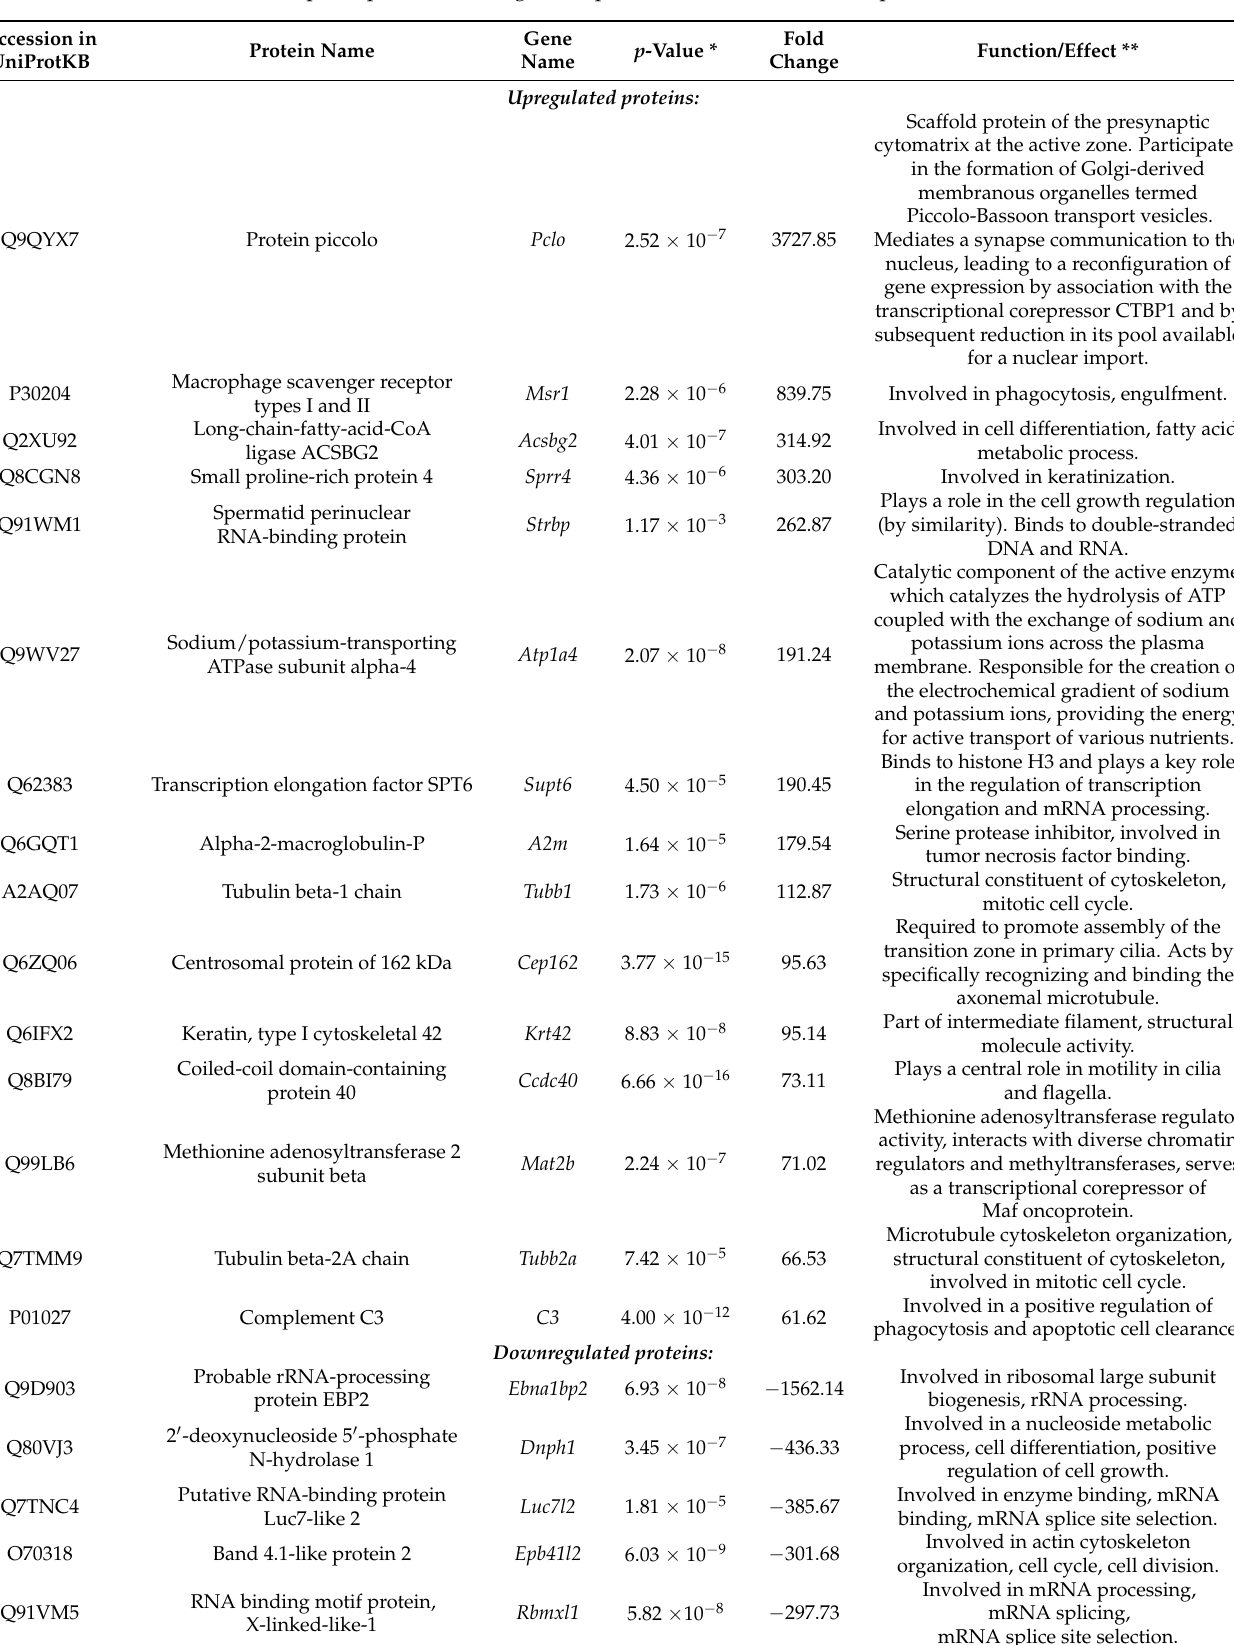
Table 1. Top 15 up- and downregulated proteins in PMJ2-R cells compared to